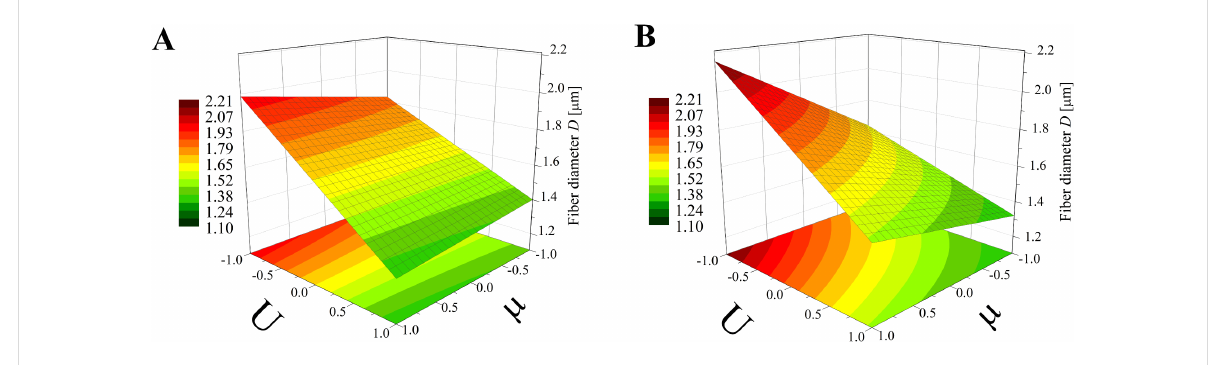
Figure 5: Response surface plots presenting the dependence of the diameter of the obtained bead-free fibers ( D ) on the electrical voltage ( U ) and the dynamic viscosity (µ) of the polymer solution for the (A) minimum flow rate ( Q = − 1) and (B) maximum flow rate ( Q = 1) .